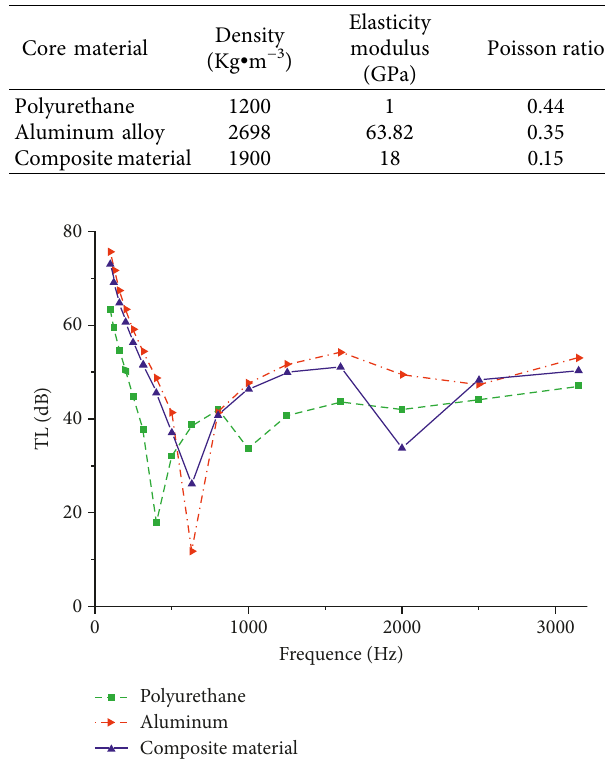
Figure 12: Influence of core thickness on sound insulation curve of SPS. Table 6: Properties of core materials.